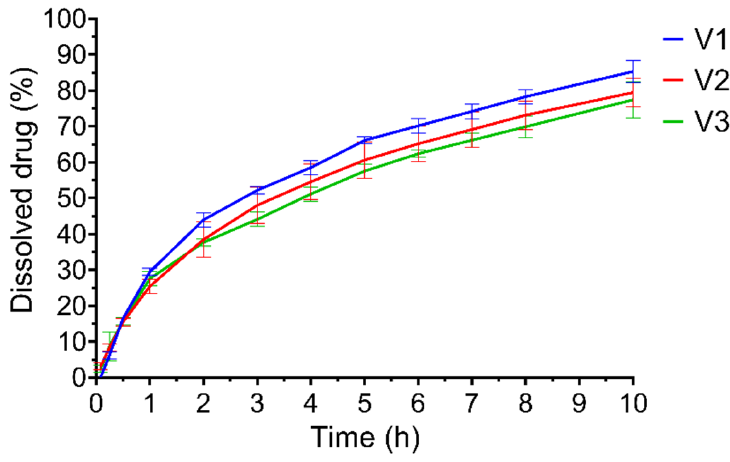
Figure 5. Dissolution profiles of the three compositions. Bars represent mean ± S.D. (n = 3). Table 3. Model fitting results for the dissolution data of the V1, V2 and V3 composition.